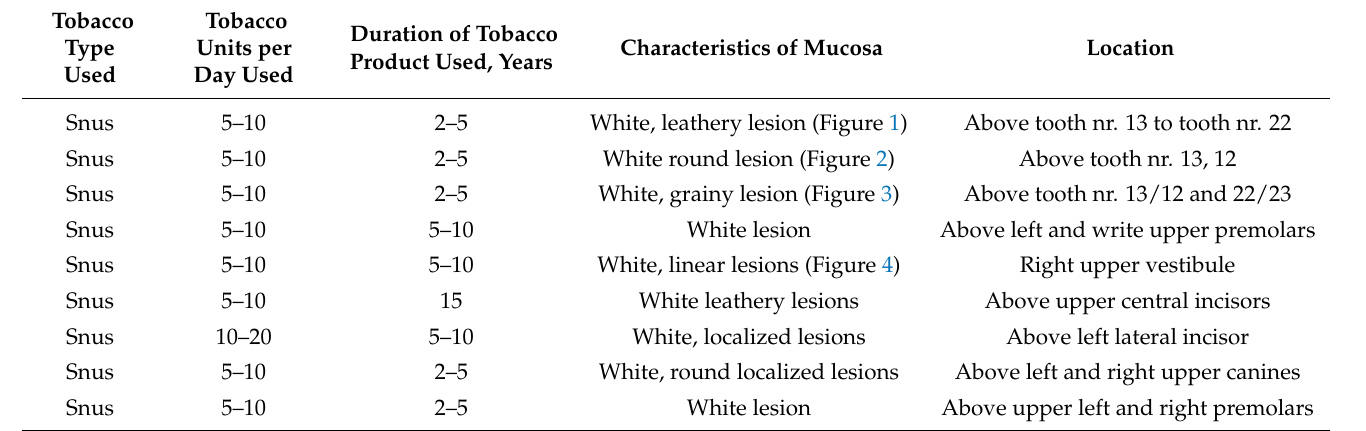
Table 3. The patterns of mucosal changes of respondents.